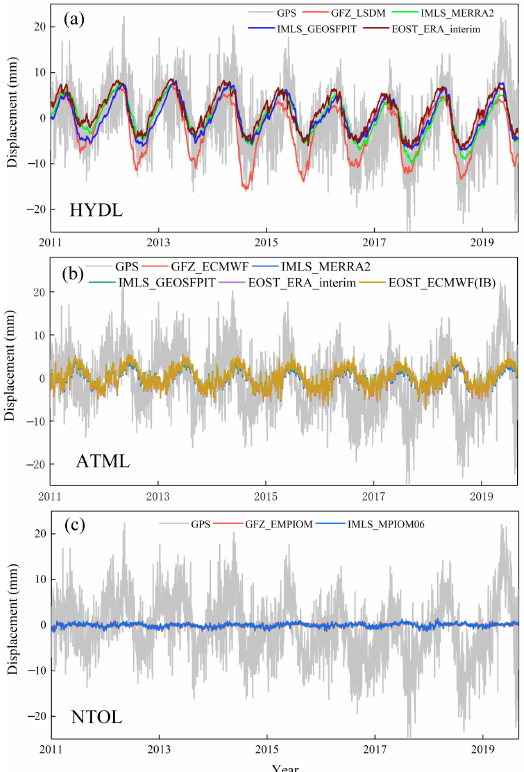
Figure 3. The environmental loading time series provided by GFZ, IMLS, EOST, and vertical GPS time series at YNCX station: ( a ) four HYDL products, ( b ) five ATML products, ( c ) two NTOL products.